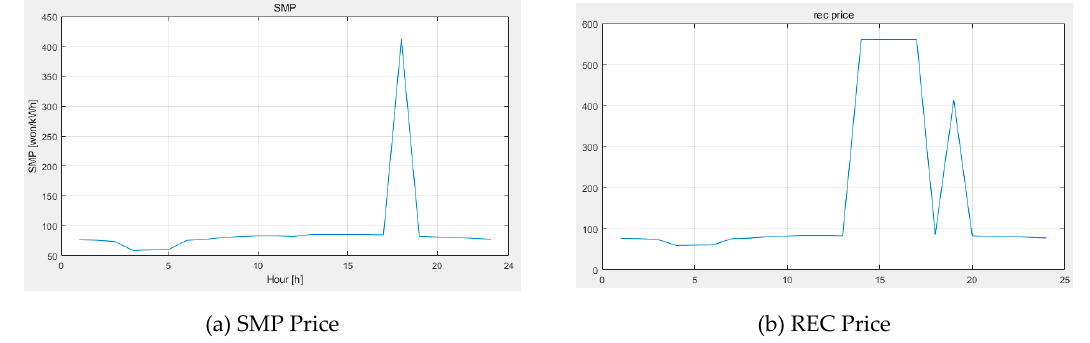
Figure 8. Input data with Critical Peak Price (CPP) (in Scenario 4).